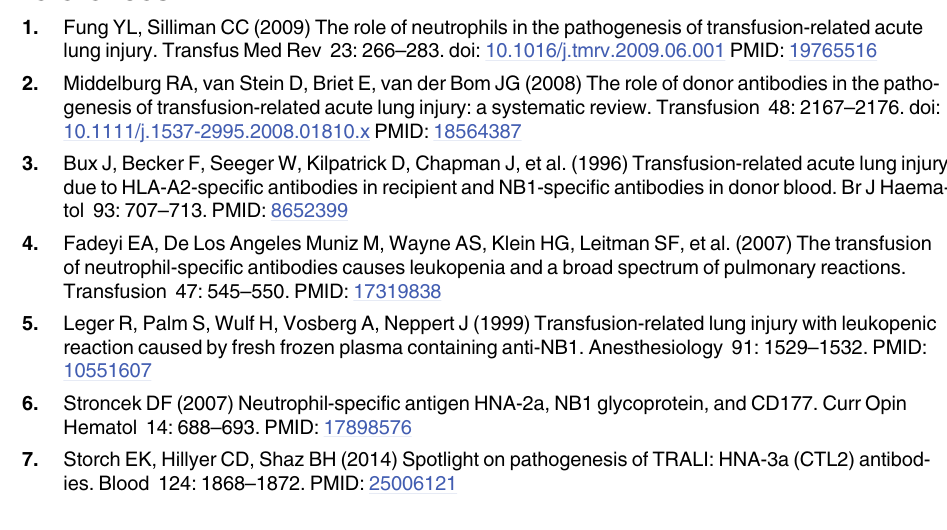
S2 Table. CD177 SNP 829A > T genotype and allele distributions in blood donors. The dis- tribution of SNP 829A > T genotypes was consistent with the Hardy-Weinberg equilibrium in 294 blood donors ( χ 2 = 0.76, P = 0.38). (cid:2) The expression of HNA-2 was based on results of flow cytometry, Western blot, and transfection analyses. S3 Table. Mutagenesis and sequencing primers for generation of CD177 constructs. a Nu- cleotide position is based on GenBank accession # NM_020406.2. b The target nucleotide muta- tion is highlighted with bold, italic, and